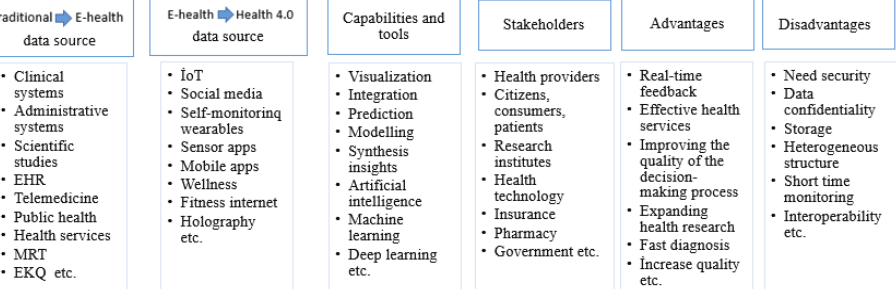
Fig. 3 . Content of the components included in the Health 4.0 data ecosystem